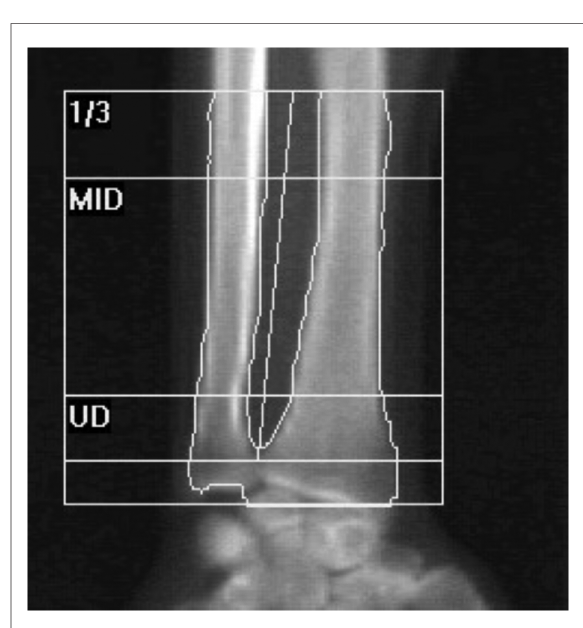
FIGURE 2 Regions of the ulna on forearm densitometry. UD, ultradistal (metaphysis); MID, middistal, 1/3; proximal.